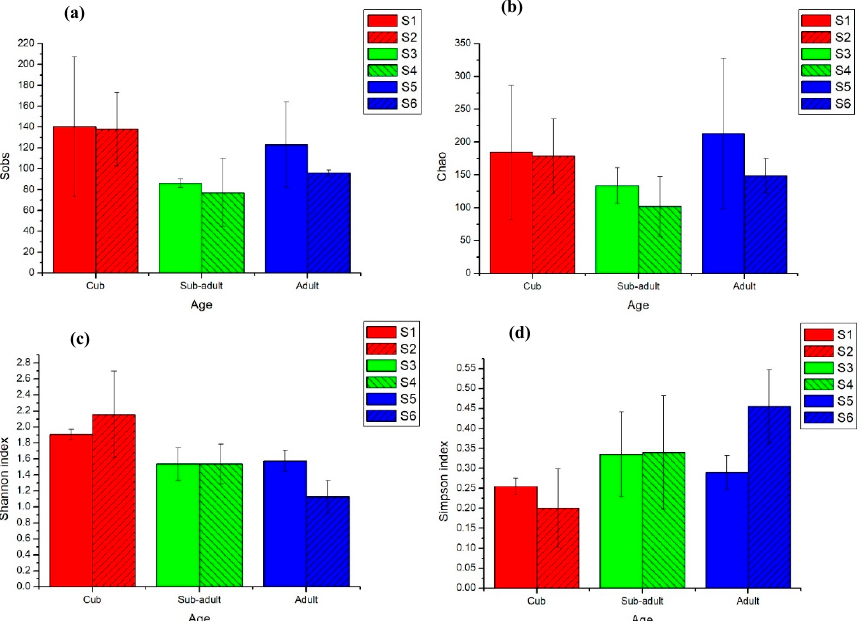
Figure 1. Intestinal bacterial Alpha diversity index of giant pandas at different developmental stages, taking the average of two experimental results in Aug (2017) and Feb (2018) of each sample. ( a ) Sobs; ( b ) Chao; ( c ) Shannon’s diversity index; ( d ) Simpson’s diversity index.